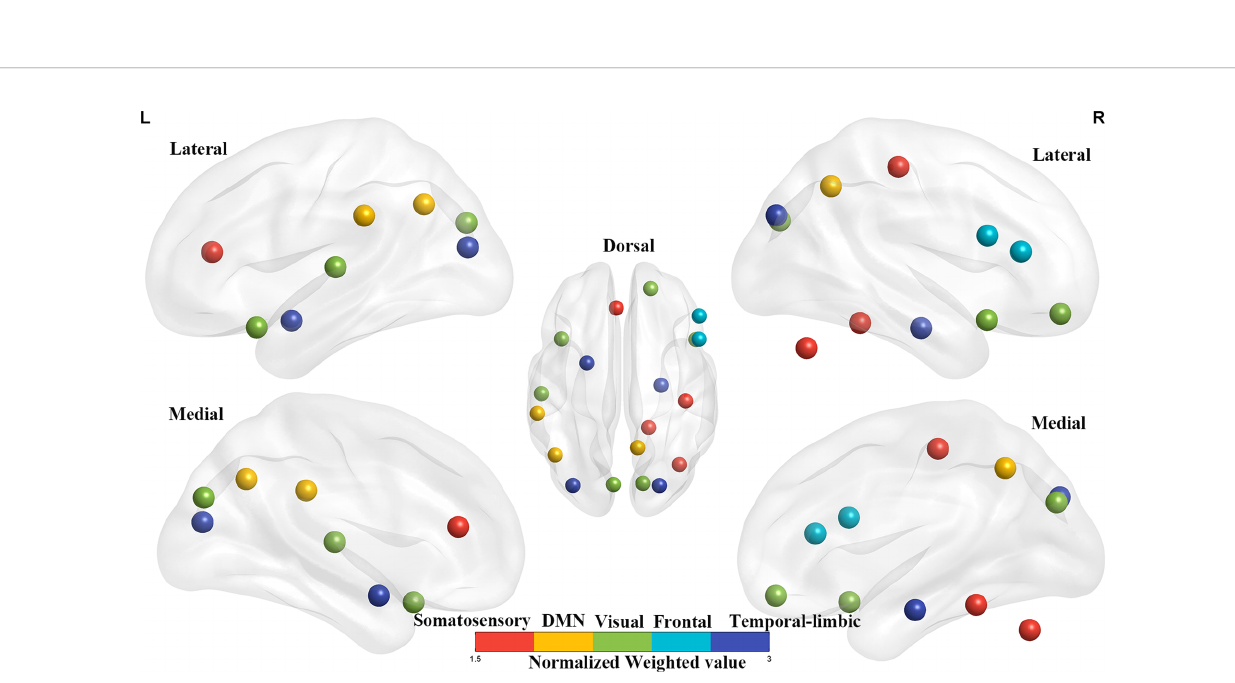
FIGURE 4 | The top 20 weighted brain regions ’ distribution spatially. The color bar denotes the percentage of total normalized weights that each brain region explains. DMN, default mode